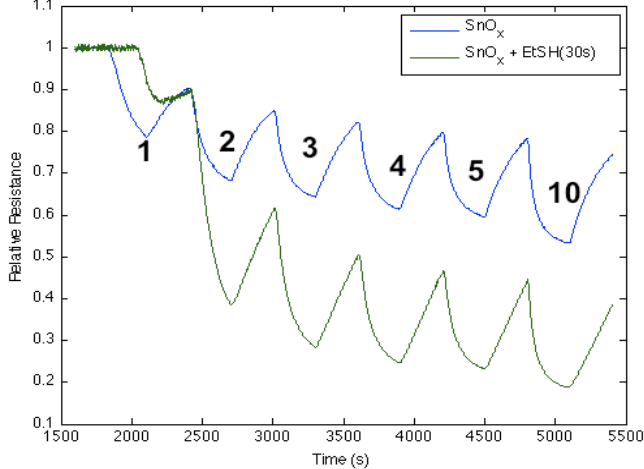
Figure 9. Response of ethanethiol-treated tin oxide nanostructure-deposited porous silicon (PS) interface to NH after exposure for 30 s ( green line ) vs. only tin oxide ( blue line ). 3